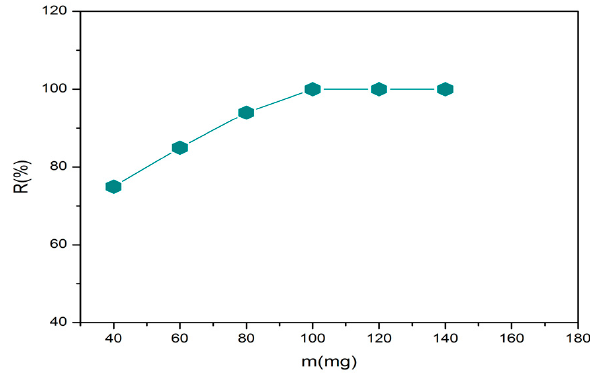
Figure 2. Effect of mass on the MG adsorption using AP from aqueous solution (Ci = 5 × 10 − 5 M, T = 303K).